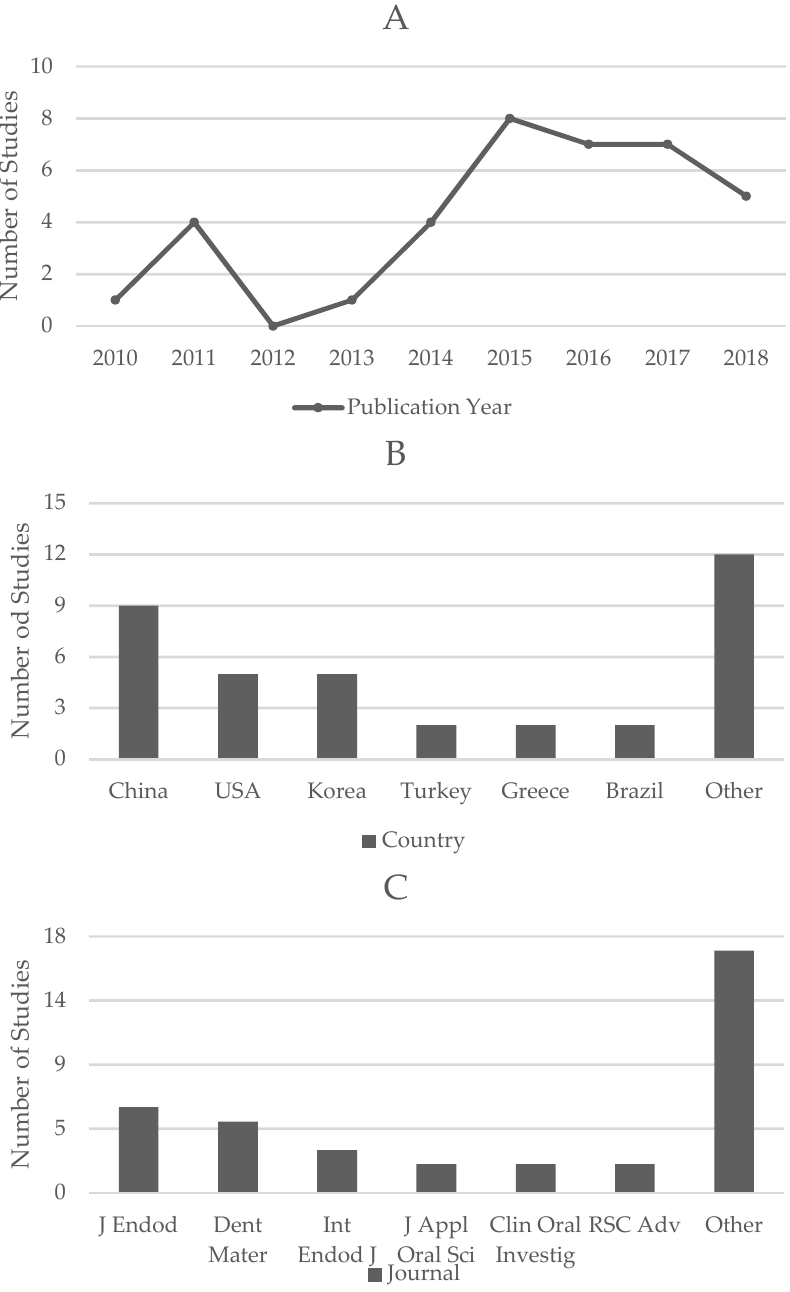
Figure 3. Bibliometric Analysis: distribution of included studies by year of publication ( A ), country ( B ) and journal ( C ). Studies included in the category “other” only appear once for the given bibliometric parameter.